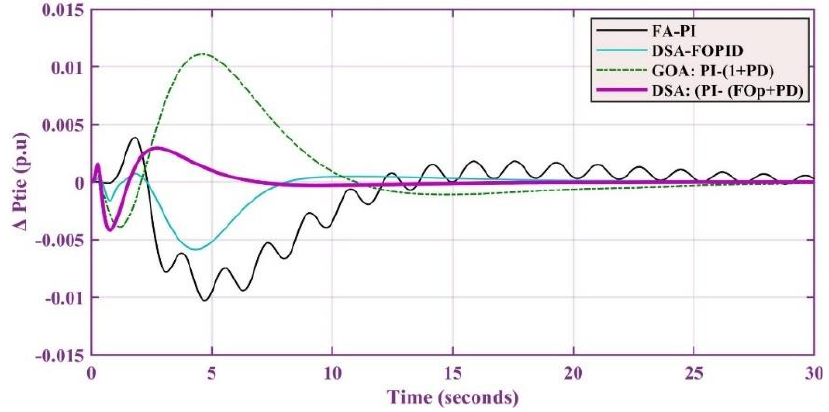
Figure 8. Tie-line power exchange response at 1% load change .